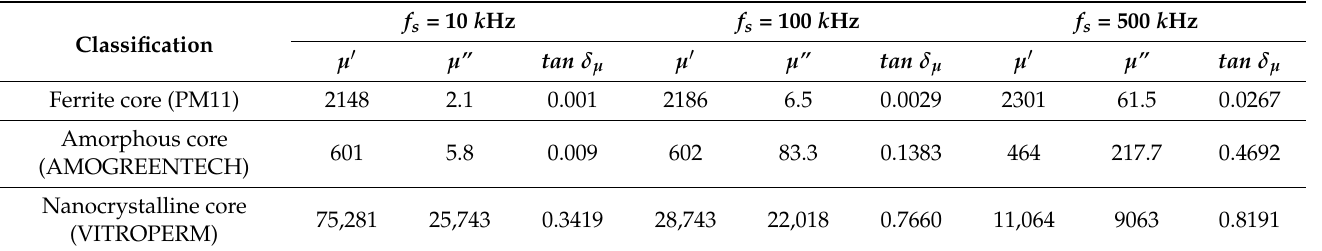
Table 2. Experimental results for different core